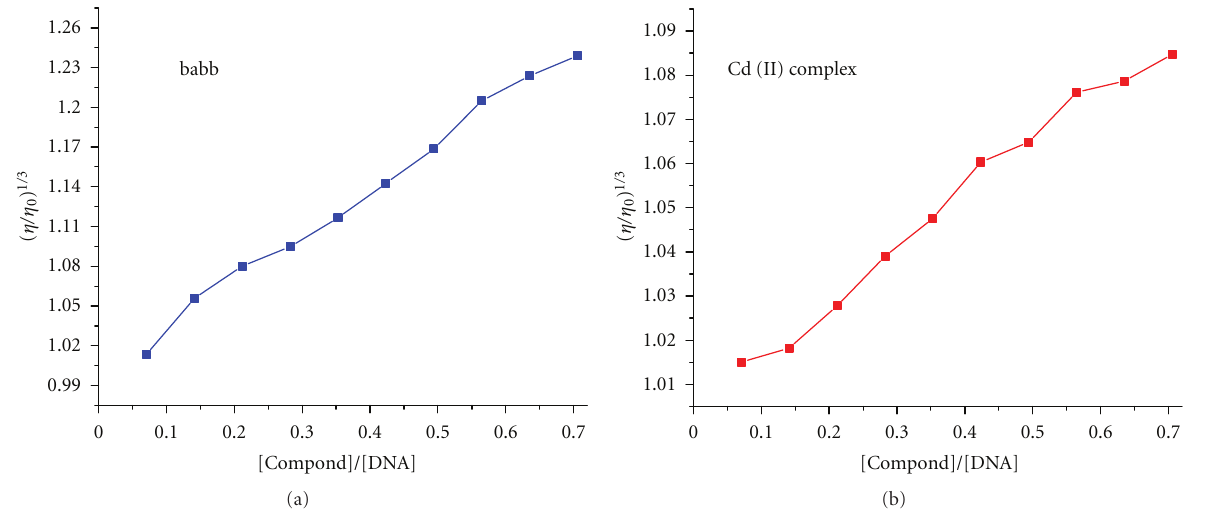
Figure 4: E ff ect of increasing amounts of the ligand babb (a), Cd (II) complex (b) on the relative viscosity of CT-DNA at 25 ( ± 0.1) ◦ C in 5mmolL − 1 Tris-HCl bu ff er (pH = 7 . 2, [DNA] = 5 × 10 − 5